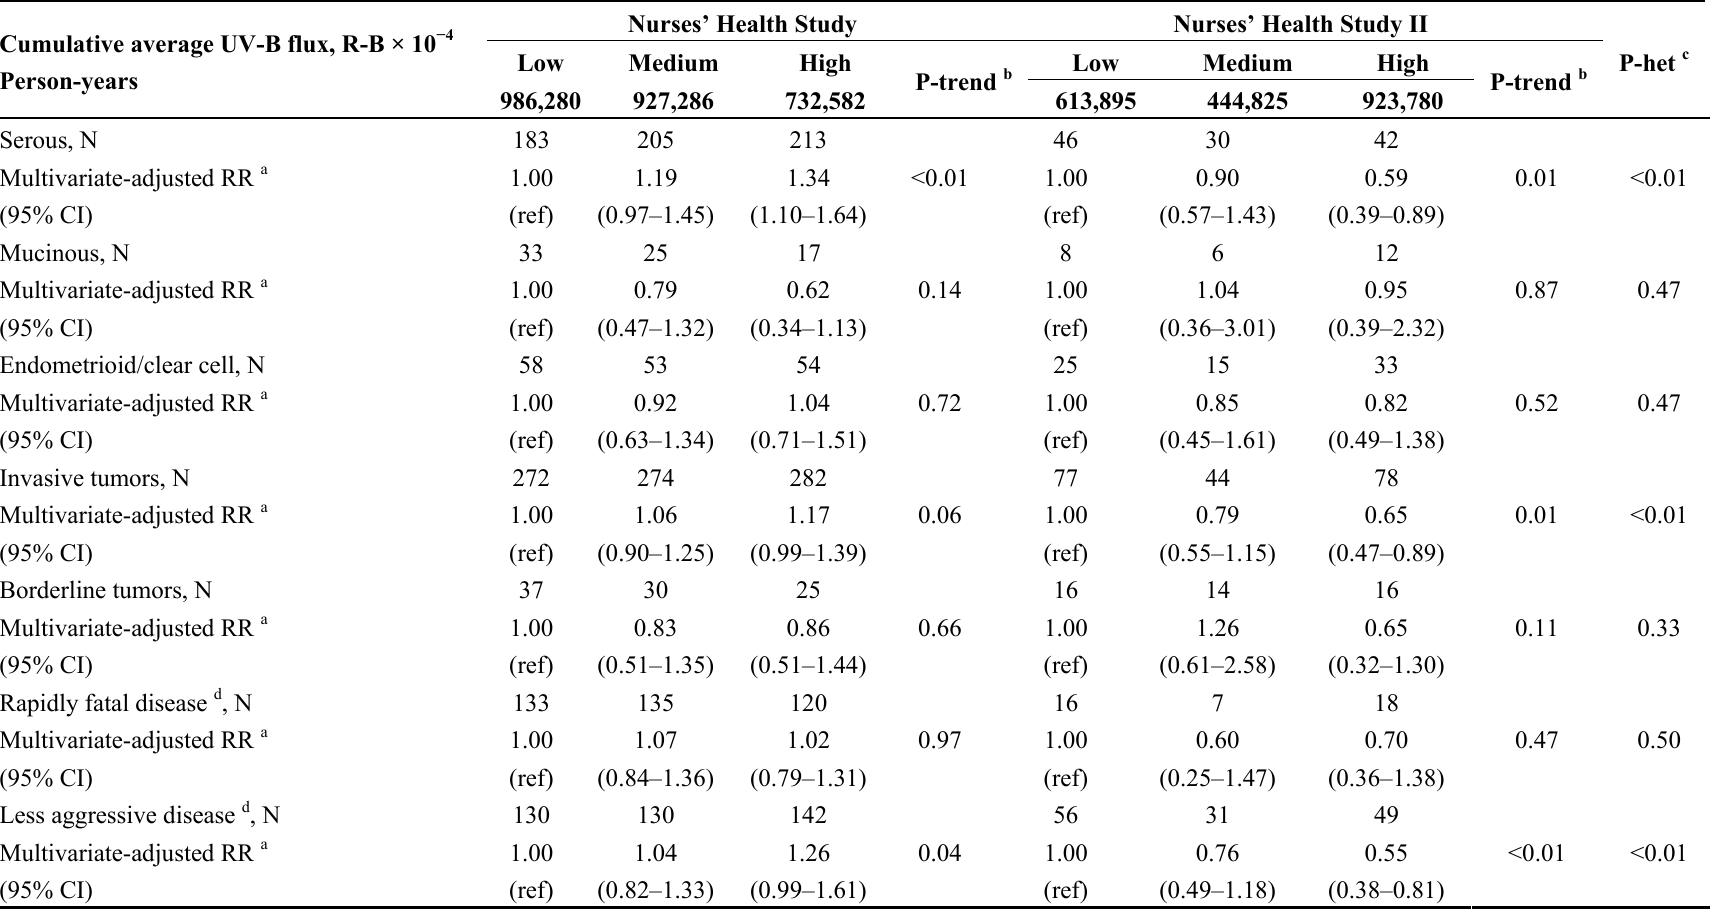
Table 4. Cumulative average UV-B flux association with histologic subtypes of ovarian cancer in NHS and NHS